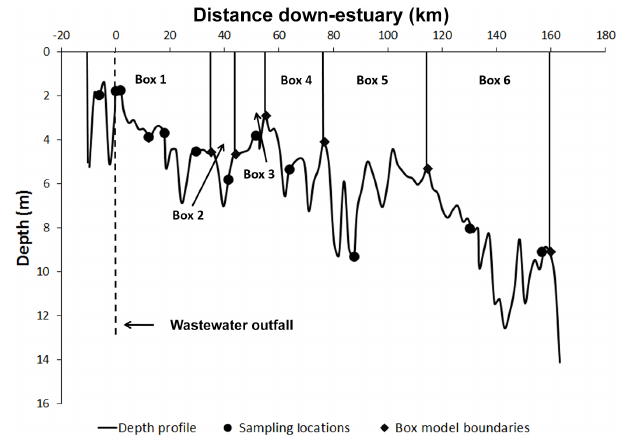
Figure 2. Plot of the Potomac Estuary depth with distance down- estuary, with the Blue Plains wastewater treatment plant at distance zero, showing the location of the six boxes used in the box model